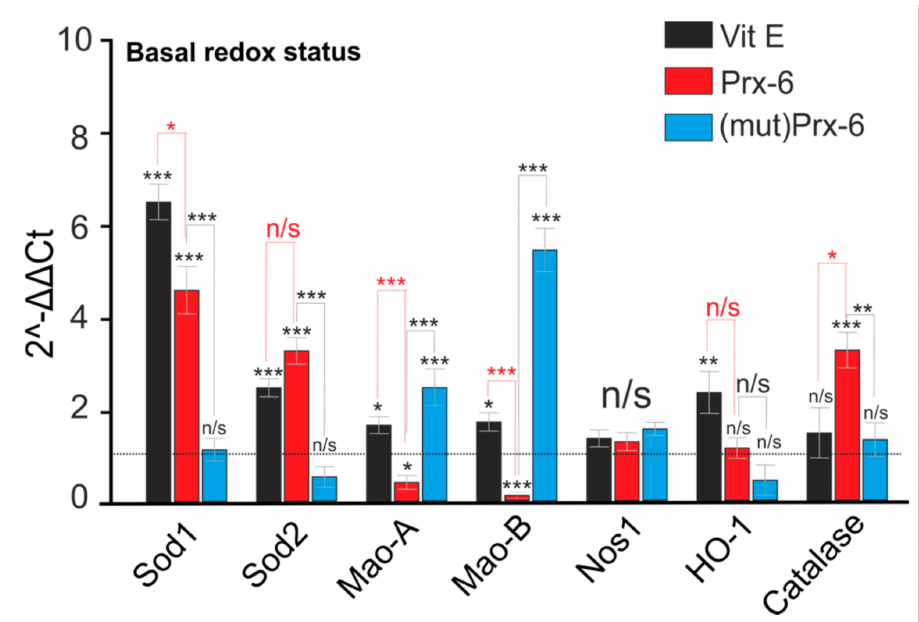
Figure 4. Effect of 24-h incubation with Vit E, Prx-6 and mutPrx-6 on the basal expression of genes involved in regulation of the redox-status. Dashed line level of gene expression in controls (without the impact of the compounds under study). Statistical significance was assessed using paired t